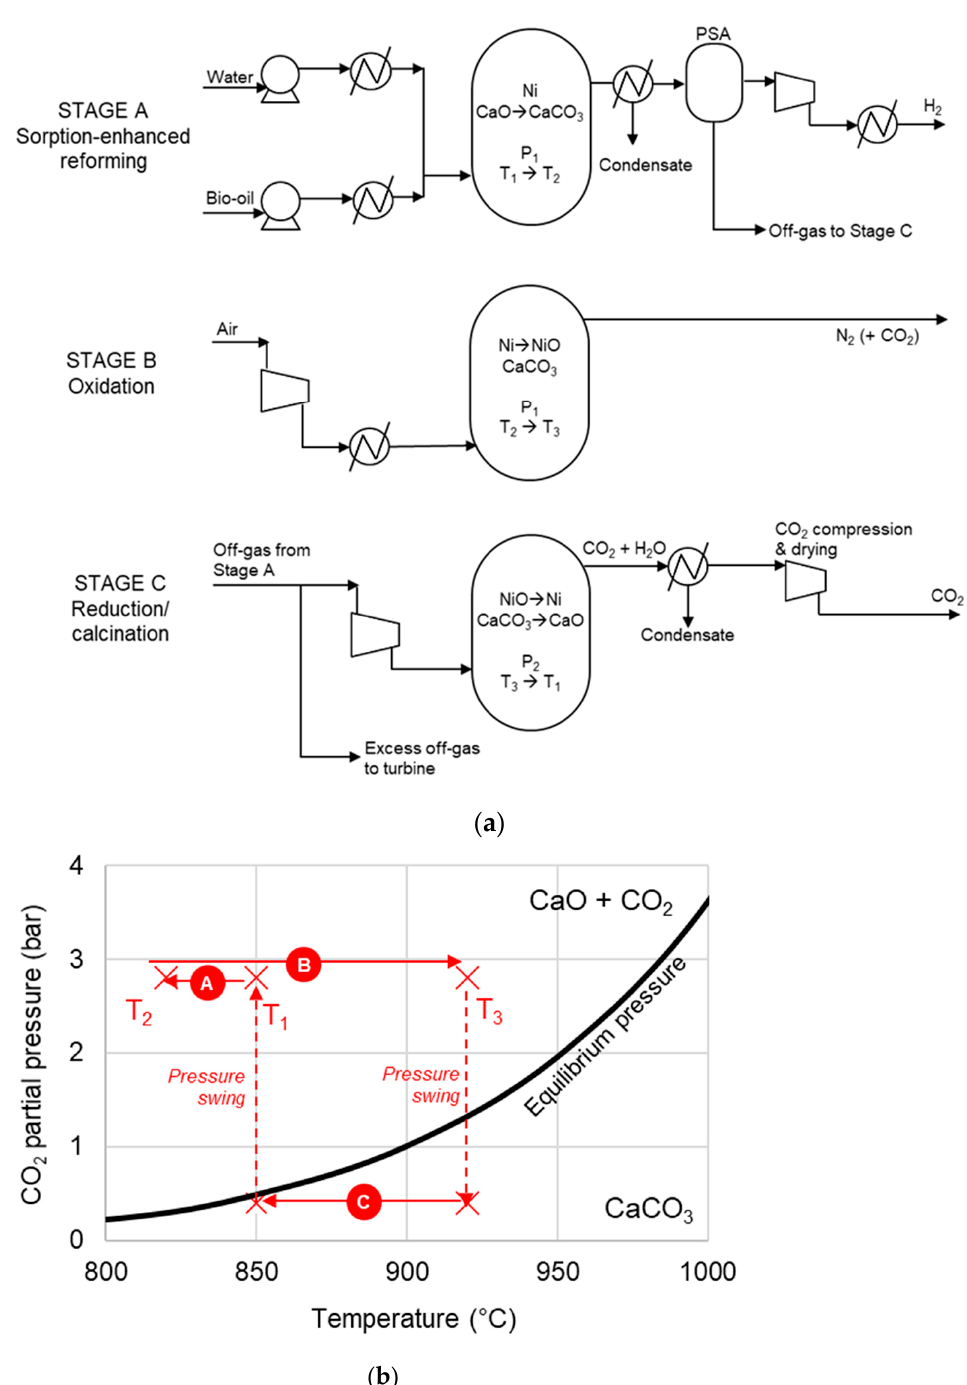
Figure 1. ( a ) Simplified process flow diagram of bio-oil SE-CLSR. ( b ) Example SE-CLSR operating conditions on CO 2 equilibrium partial-pressure diagram. CaO/CO 2 equilibrium properties from [61].